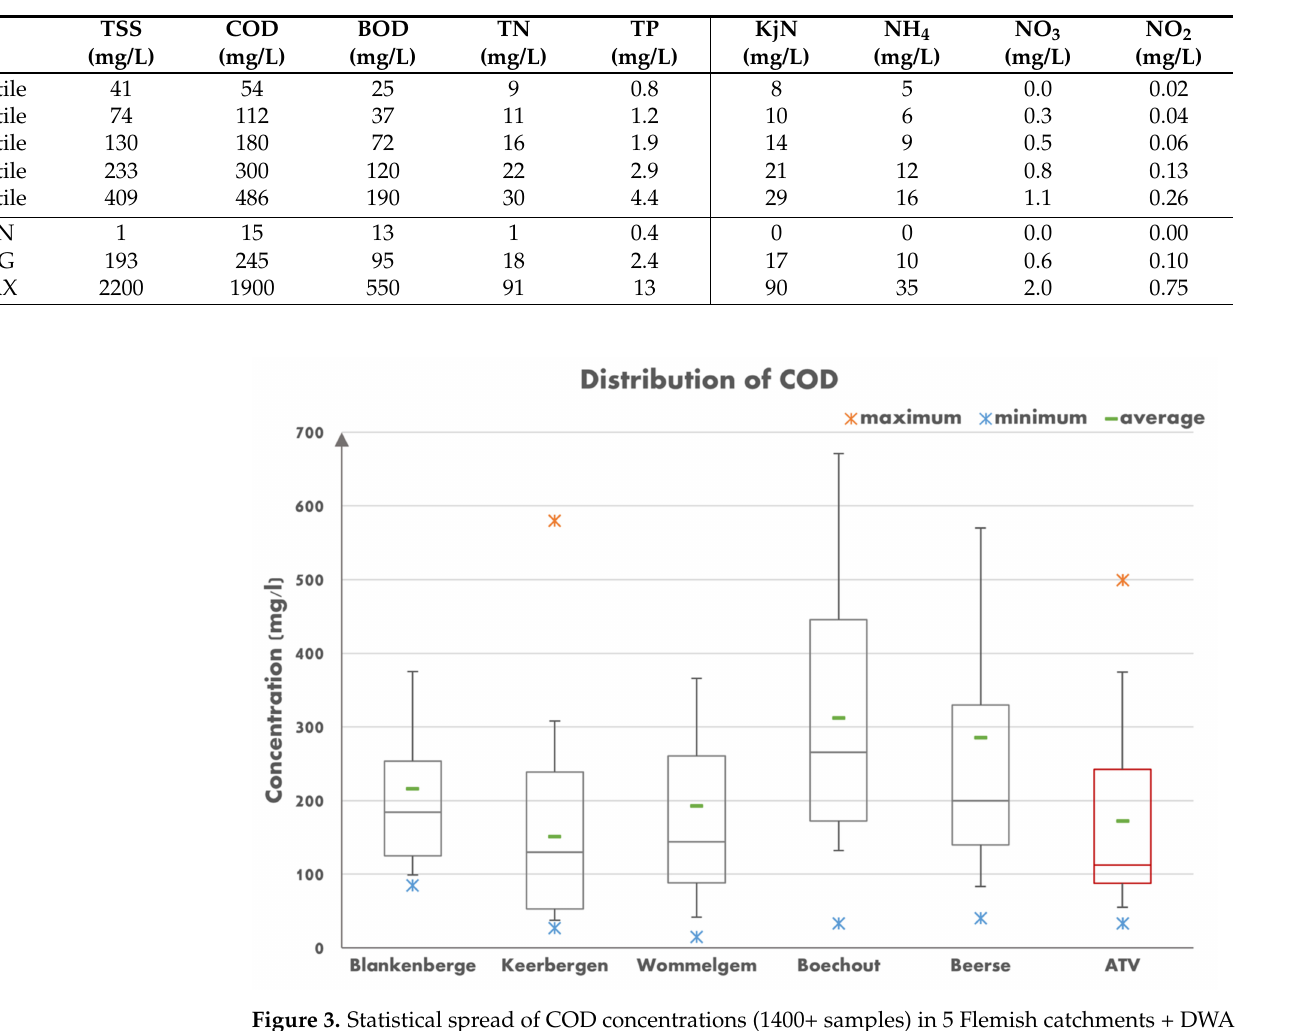
Table 2. Statistical summary of CSO concentrations of 1400+ samples of 5 measurement campaigns in Flanders.